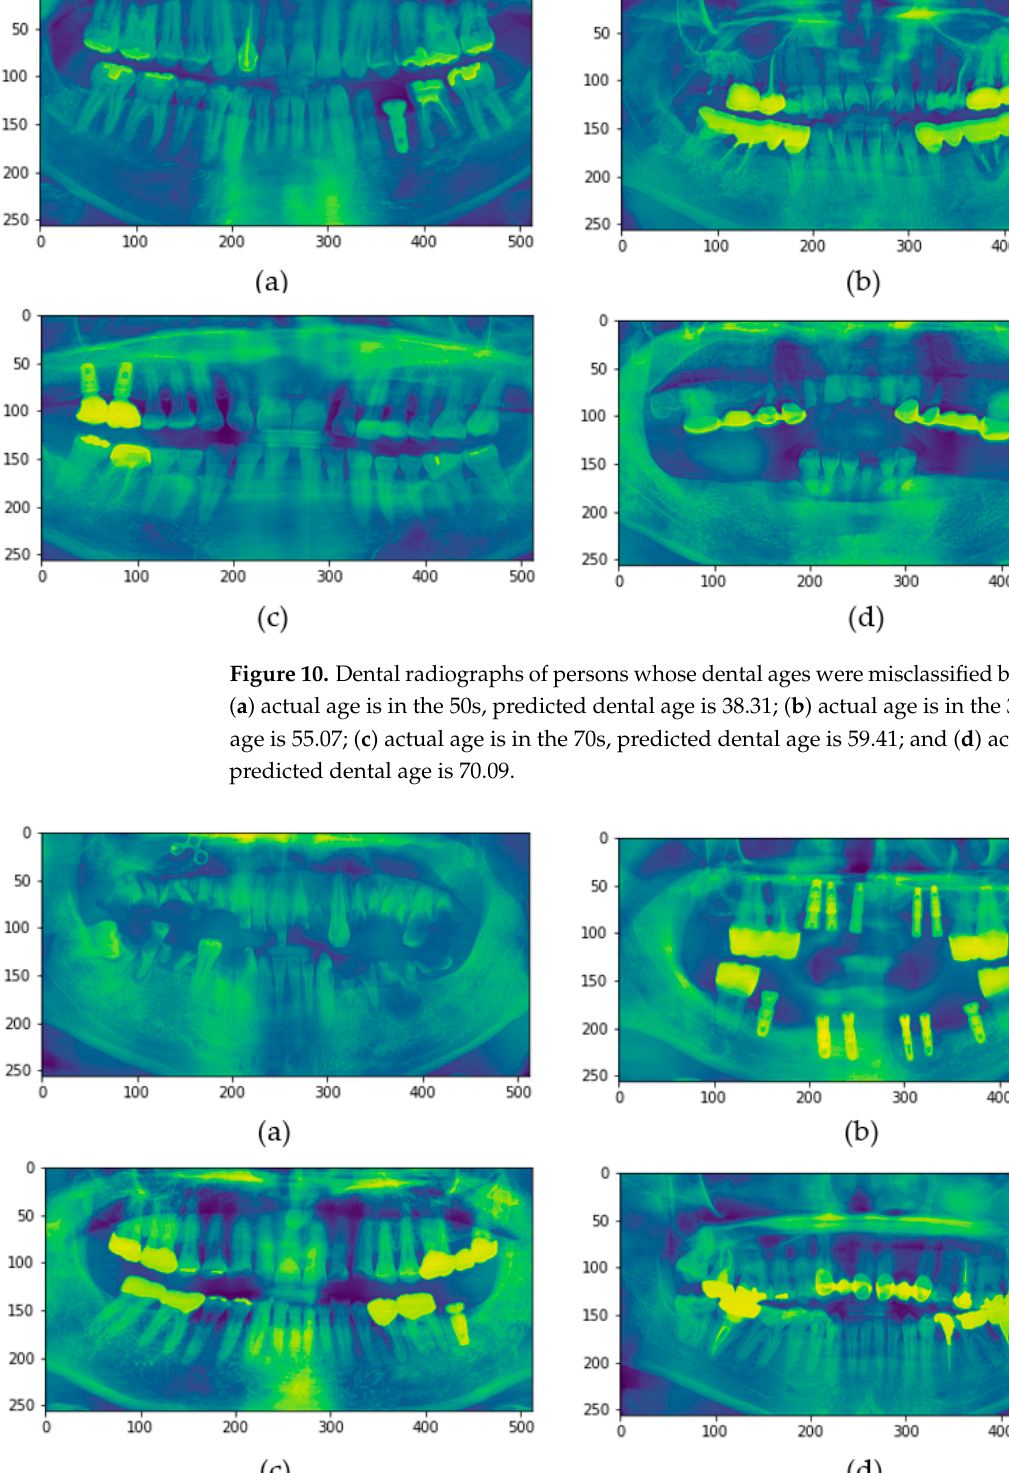
Figure 11. Dental radiographs of persons whose dental ages were misclassified by more than 25 years: ( a ) actual age is in the 20s, predicted dental age is 67.22; ( b ) actual age is in the 20s, predicted